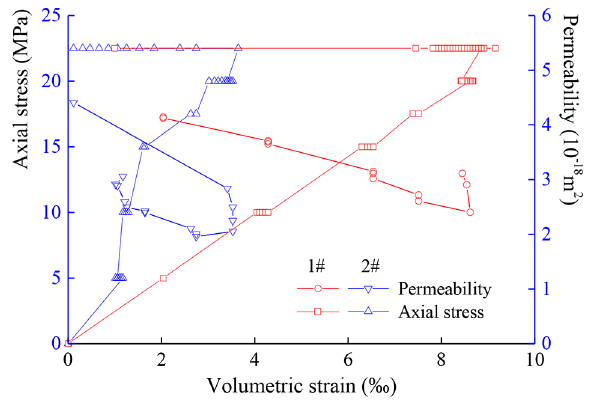
Fig. 6 Axial strain and permeability evolution cures